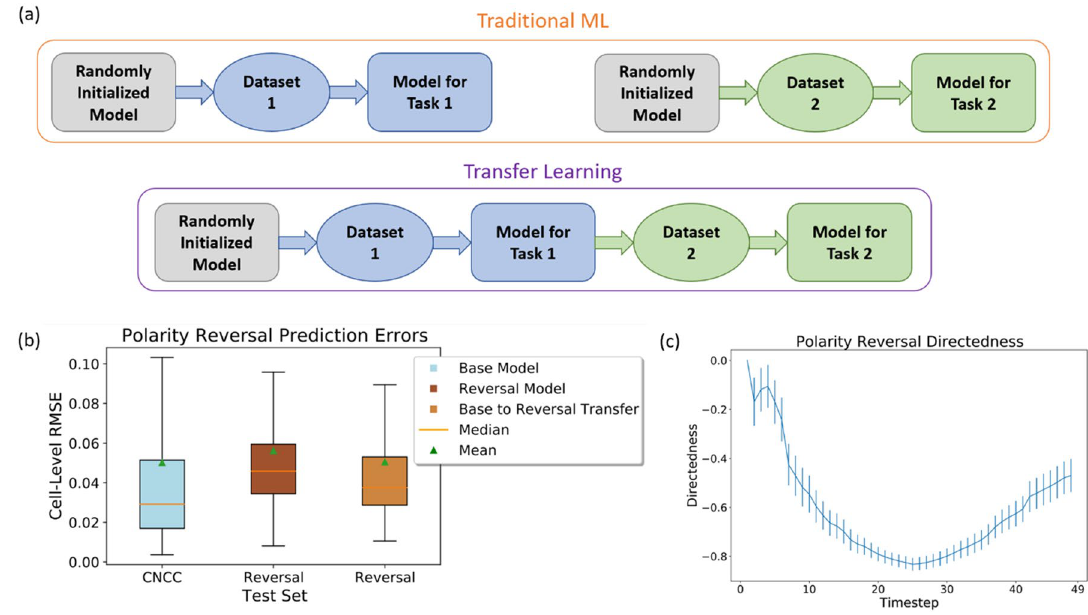
Figure 5. ( a ) Diagram comparing the traditional machine learning training approach, which involves training a separate randomly initialized model for each learning task, with the transfer learning approach, which involves training a model for one task and then retraining that model on another dataset to perform a related task. ( b ) Distributions of cell-level RMSE values for the base model, a model training only on the reversal dataset, and a model which uses transfer learning to retrain the base model for the polarity reversal task. The boxes represent the middle 50% of error values and the whiskers extend to the minimum and maximum error values. ( c ) Plot of average directedness over time for the polarity reversal dataset, with error bars representing standard error of the mean for each timestep to illustrate the spread of directedness values at each